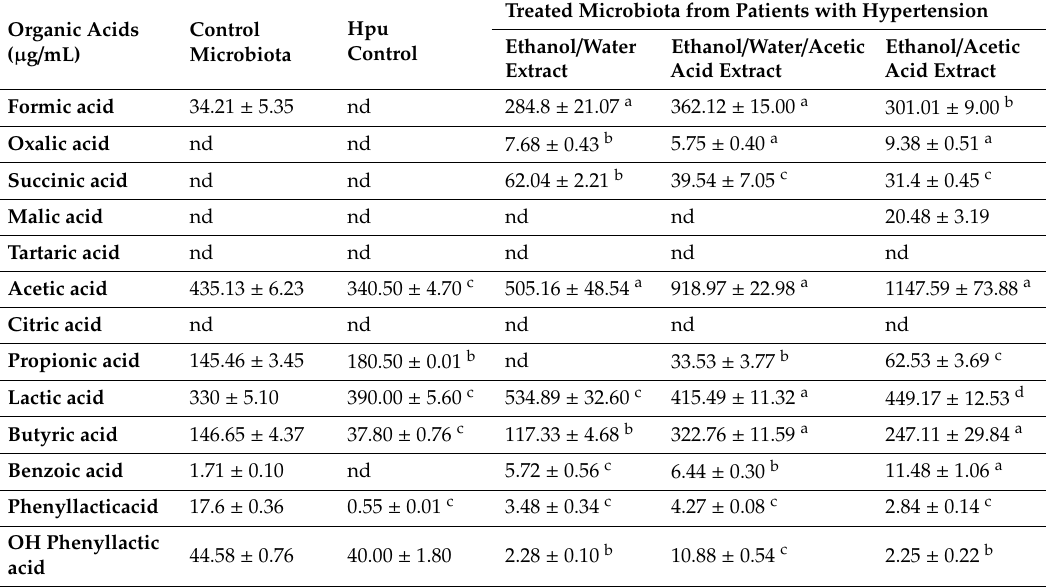
Table 1. Organic acids levels ( µ g / mL) obtained after in vitro tests through the GIS1 system as a measure of the impact of curcuma extracts (administered as capsules) associated with the microbiota metabolic